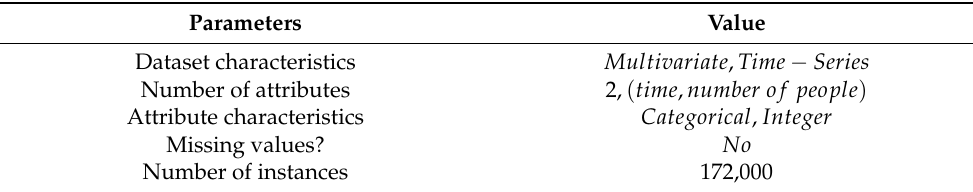
Table 3. Dataset description.